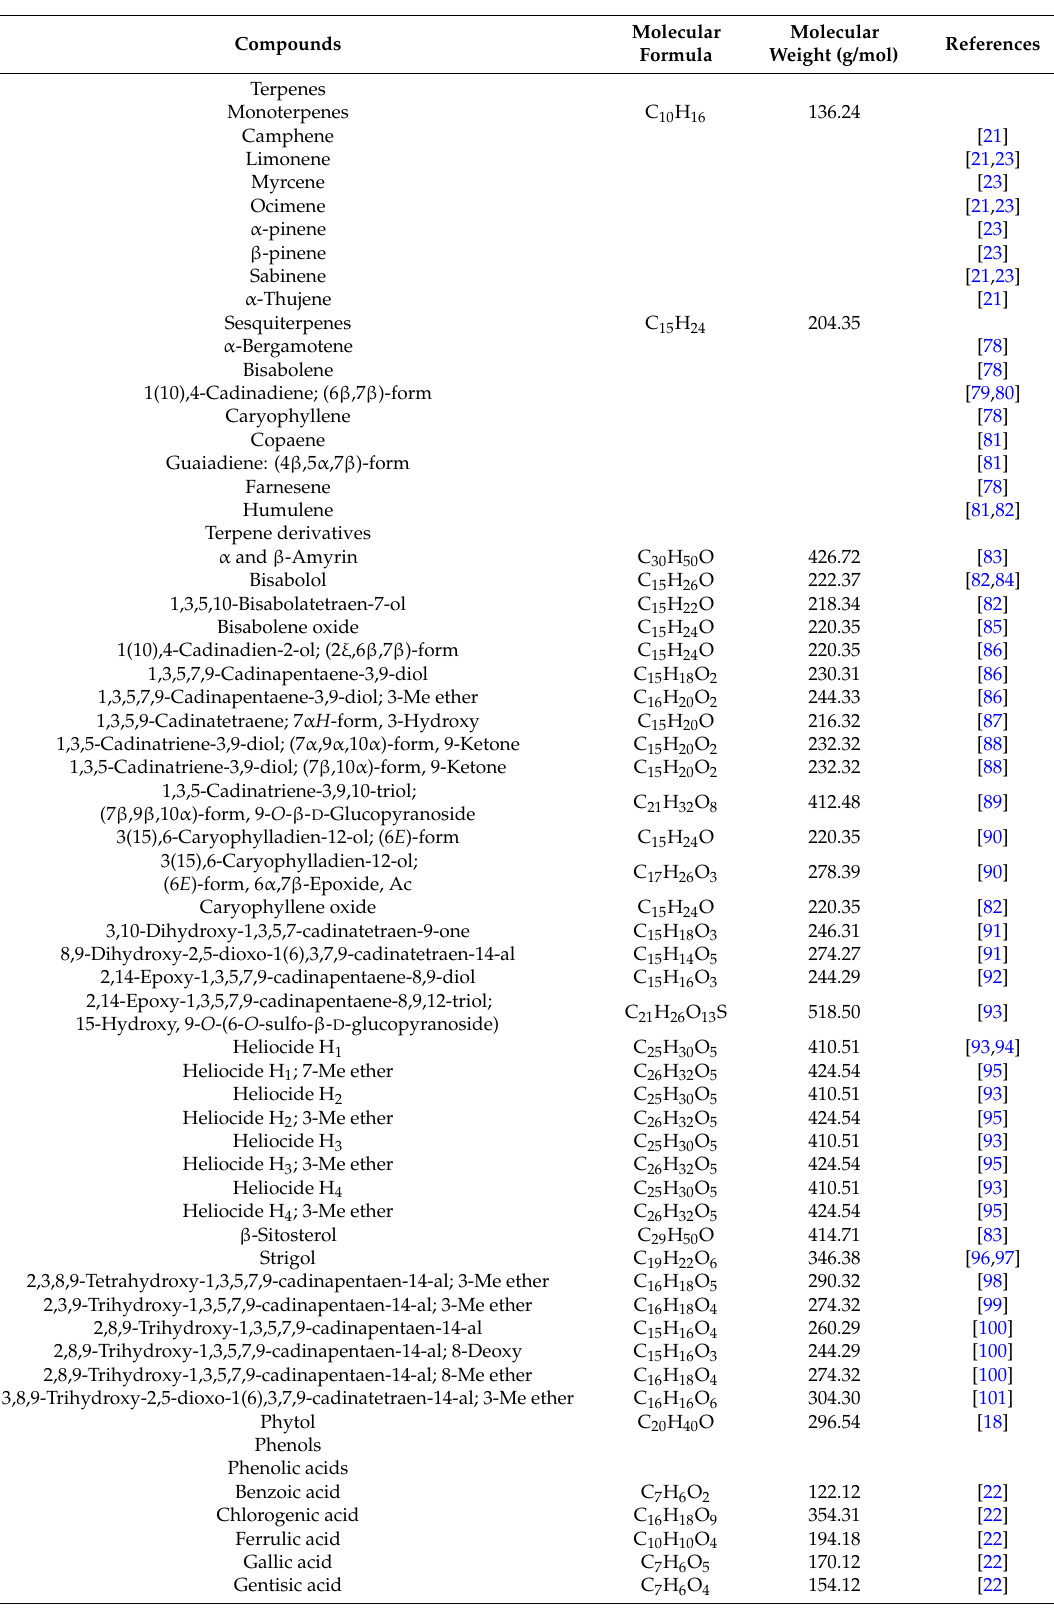
Table 1. Chemical compounds isolated from cotton ( Gossypium